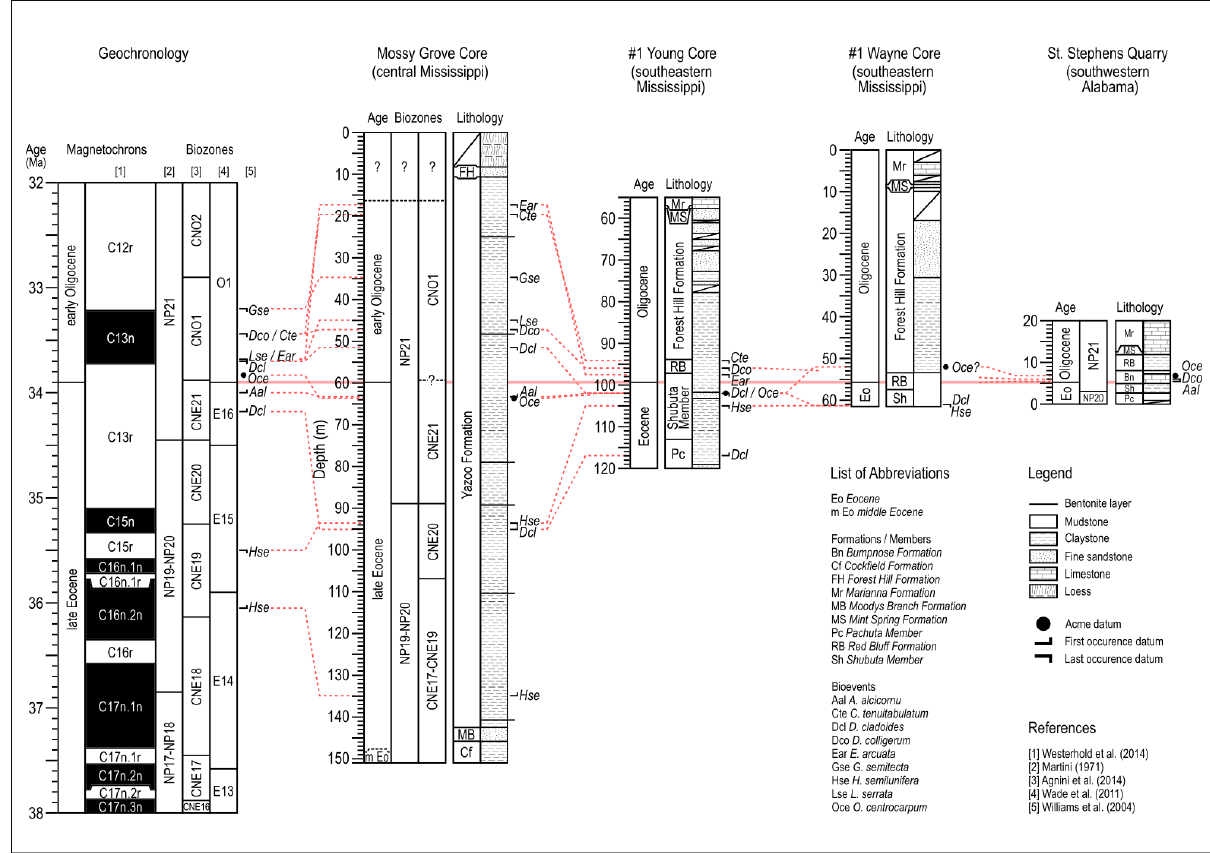
Figure 3. Stratigraphic correlation between the Mossy Grove core and the other three sections from Mississippi and Alabama (Jaramillo and Oboh-Ikuenobe, 1999). Lithology at the Mossy Grove follows Dockery III et al. (1991) and the timescale for all sections follows Westerhold et al. (2014). See discussion about dinocyst bioevents in Sect.